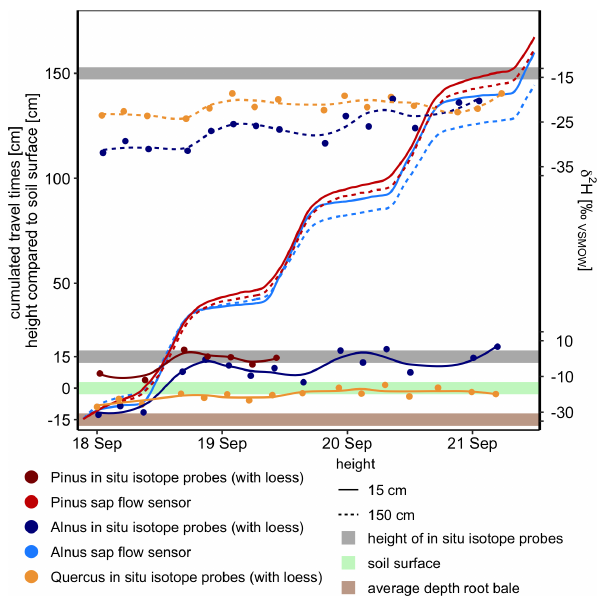
Figure 5. Isotope tracer breakthrough of Alnus , Pinus and Quercus at 15 and 150cm stem height and cumulated sap flow of Alnus and Pinus (no reliable sap flow data for Quercus ). Tracer-based travel times (i.e., time of first response of isotope tracers) for Alnus and Pinus were similar to sap-flow-based travel times considering the distance from an average rooting depth of 15cm below surface to 15 and 150cm stem